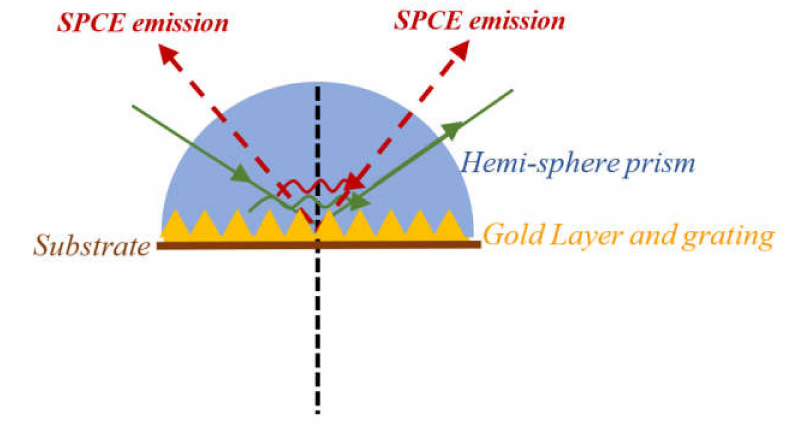
Figure 7. Scheme of SPCE based on